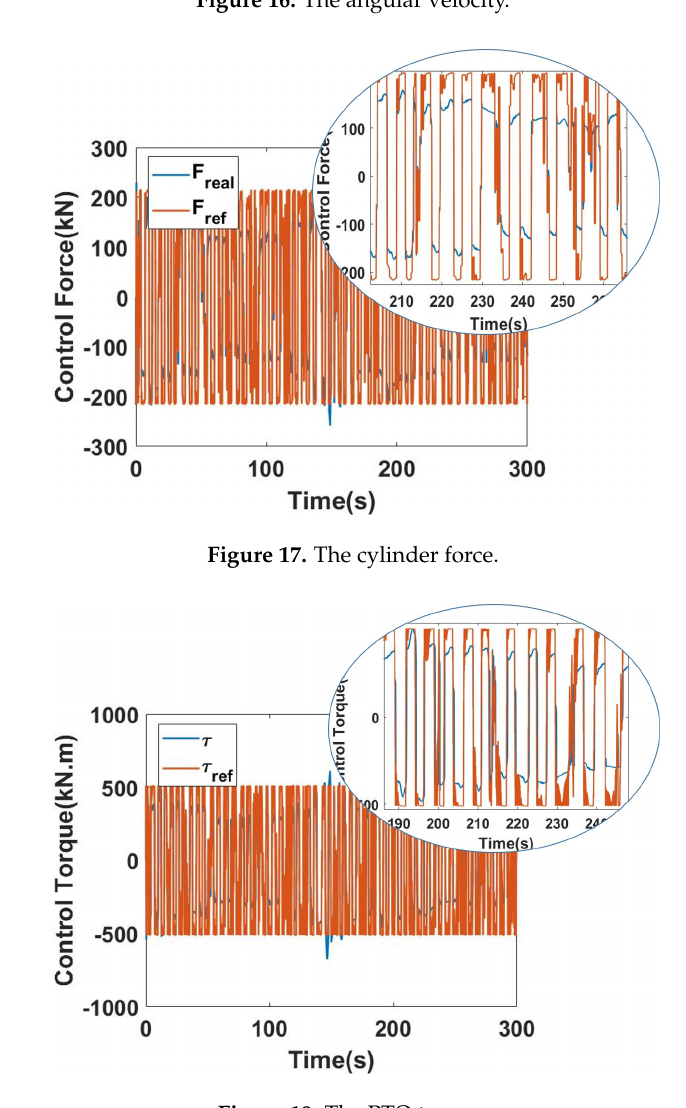
Figure 18. The PTO